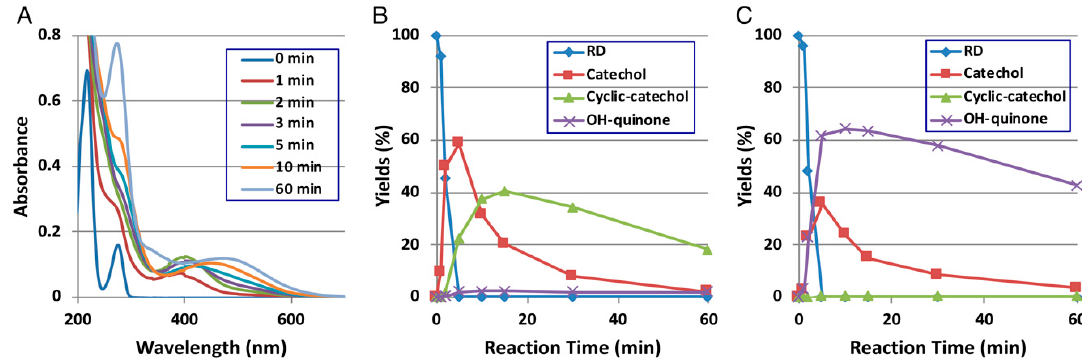
Figure 2. Time course of the tyrosinase-catalyzed oxidation of RD. ( A ) UV/Vis spectral changes over time at pH 5.3; ( B ) HPLC following oxidation at pH 5.3, the reaction being stopped by the addition of NaBH 4 followed by the addition of HClO 4 ; ( C ) HPLC following oxidation at pH 5.3, the reaction being stopped by the addition of HClO 4 alone. Adapted from Ito et al. [9].